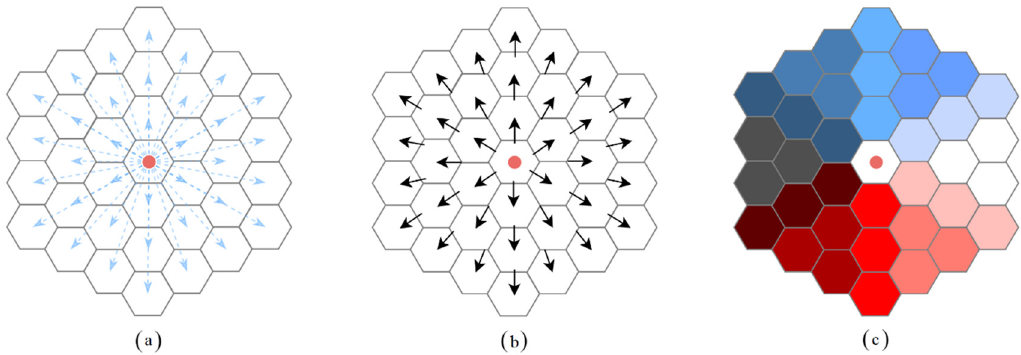
Figure 2. An activity location (red point) and the unit vectors generated based on this location. The honeycomb represents a view of the activity location from above. There are three functions for visualization: ( a ) The arrows represent the unit vector, but the length of each arrow is not the same, which could easily confuse readers; ( b ) these unit vectors are projected on the cell center; the arrows point to the centroids of destination cells, and the length of each arrow is the same; ( c ) the figure uses color to represent the directions, such that blue and red represent the northern and southern directions, and dark and light represent the western and eastern directions,